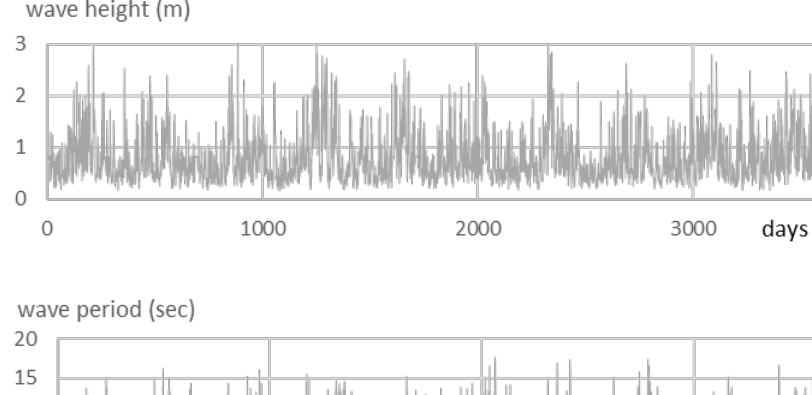
Figure 9. In the time period: 1 July 2003 to 31 March 2013, first row: autocorrelation up to 50 lags for each sea condition variable. Second row: cross-correlation between pairs of sea condition vari- ables. Blue lines are the auto/cross correlation function of the original data, and the red lines corre- spond to those of the simulated data. Note: In all plots the horizontal axis is the lag time in days and the vertical axis is the normalised correlation value which lies between 1 and − 1. Overall, Figure 9 shows a very good agreement between the original and synthetic data. The final step is the validation of the VAR model on an independent section of measurements; that is, the time period from 1 April 2013 to 30 June 2016. The simulated wave time series, along with their density functions is presented in Figures 10 and 11 re- spectively.